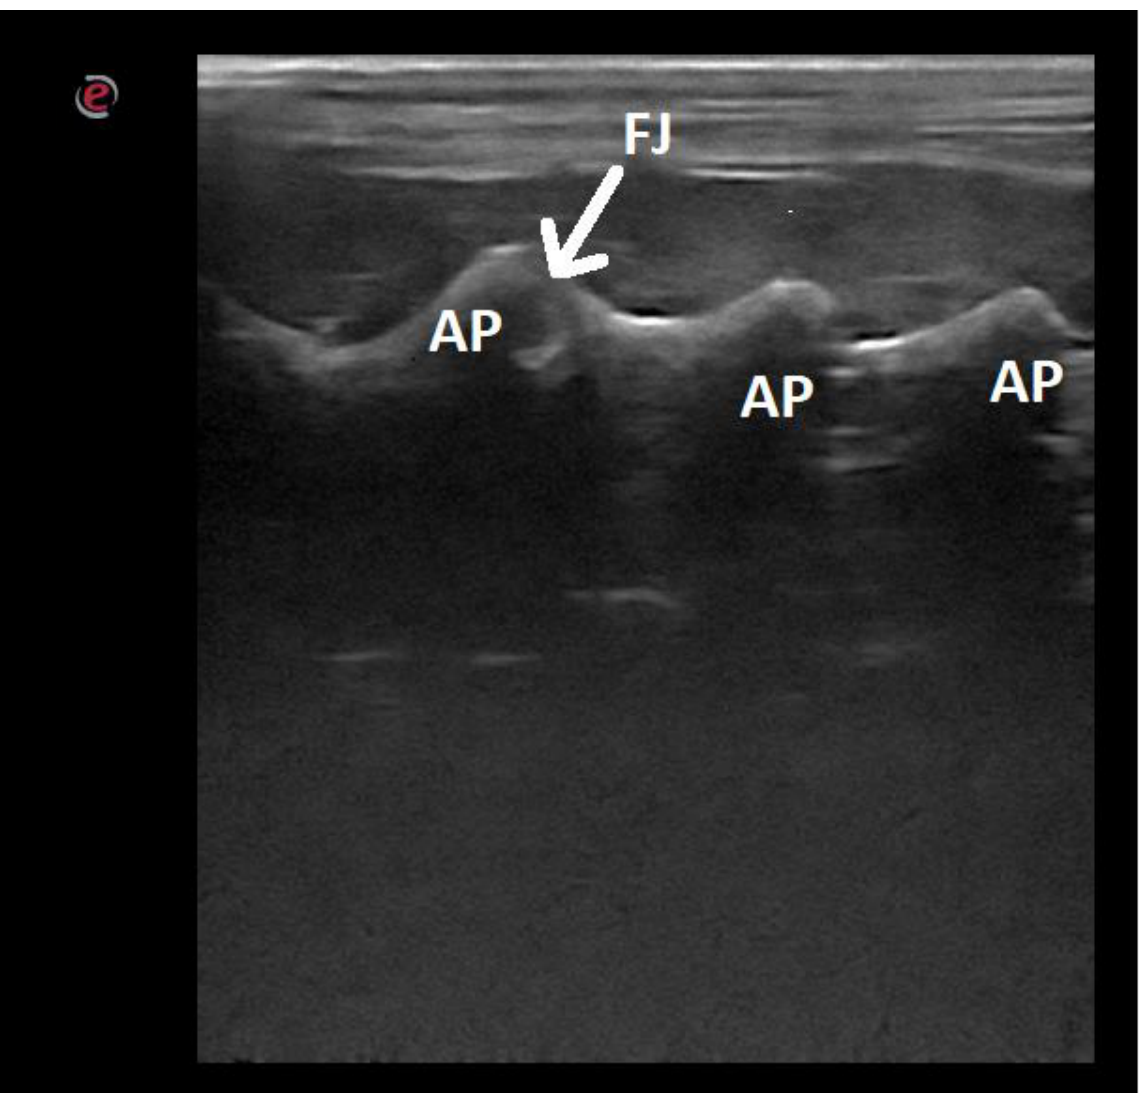
Figure 8. Ultrasonographic image of the lumbar spine of a dog in the longitudinal paramedian plane on the dorsal side: AP — articular process; FJ — facet joint.